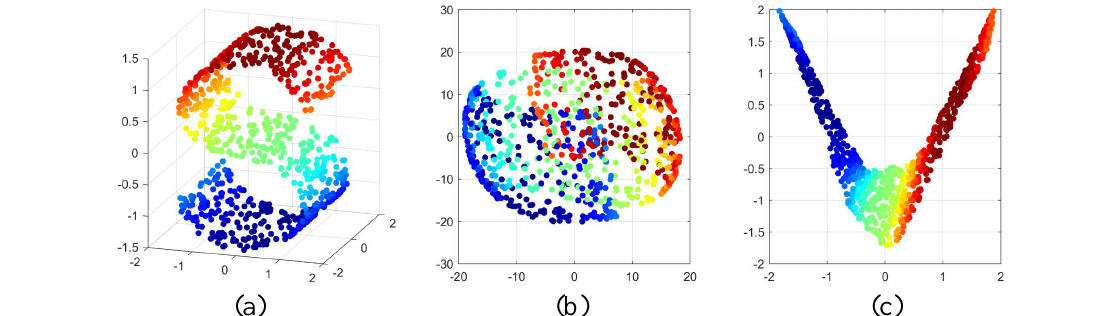
Figure 9. Illustration of manifold learning: ( a ) S-curve data set; ( b ) 2-D Kernel principal components analysis (PCA) projection using radial basis function (RBF) kernel, c = 10; ( c ) 2-D Local linear embedding (LLE) using kNN, k = 15. See [319] for more